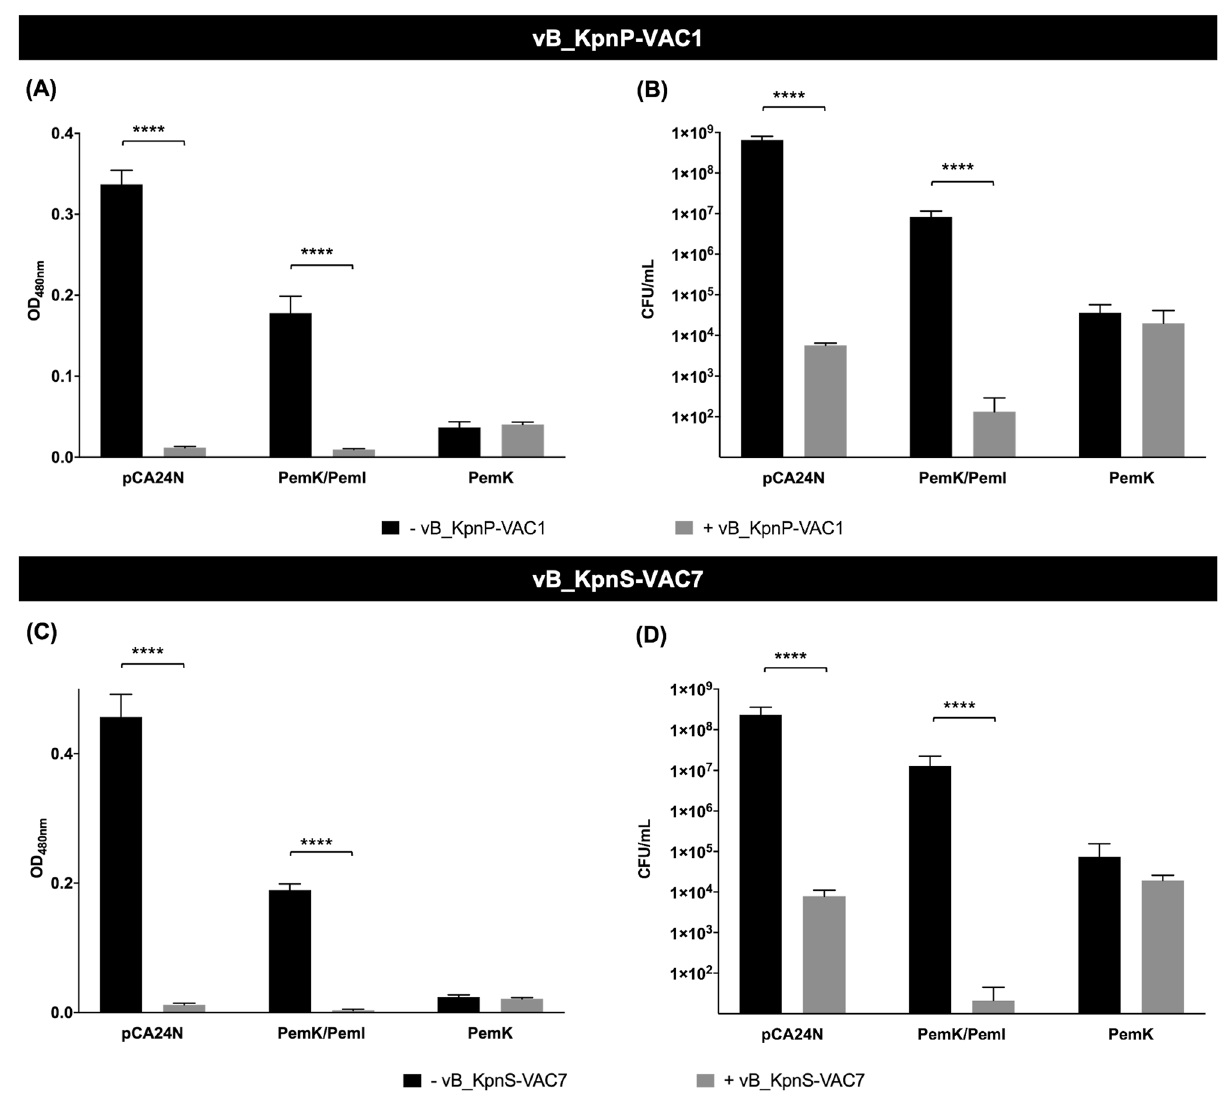
Figure 6. ( A , C ) Measurement of the metabolic activity by the colorimetric assay (WST-1 based) and ( B , D ) measurement of viability by CFU/mL counts of the transformed strains ATCC10031/pCA24N, ATCC10031/ pCA24N ( pemK/pemI ) and ATCC10031/pCA24N ( pemK ) after induction with 1 mM IPTG for 2 h and infection with phages vB_KpnP-VAC1 ( A , B ) and vB_KpnS-VAC7 ( C , D ) at an MOI of 0.1. The controls were the transformed strain without phage infection. In all cases, no significant differences (p-value > 0.05) were observed between the strain ATCC10031/pCA24N ( pemK) infected with phages and the uninfected strain, in terms of metabolic activity and cell viability, possibly indicating that the cells are in a state of cell dormancy. ****p-value < 0.001. The errors bars represent the standard deviation of the three experiment